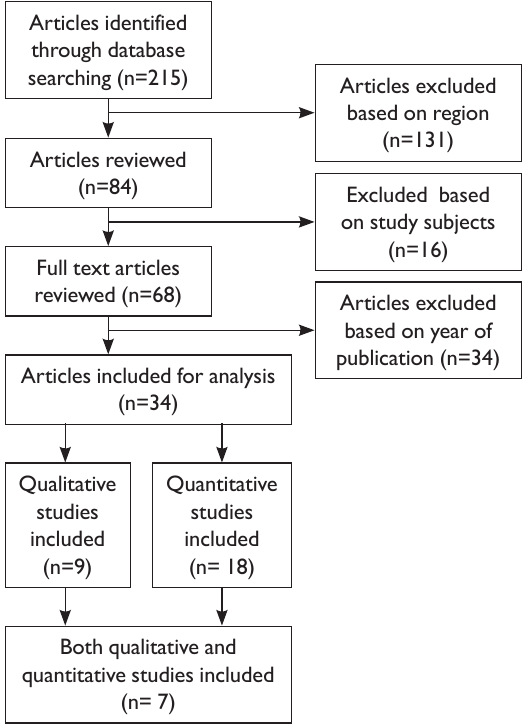
Figure 1. Process for searching the